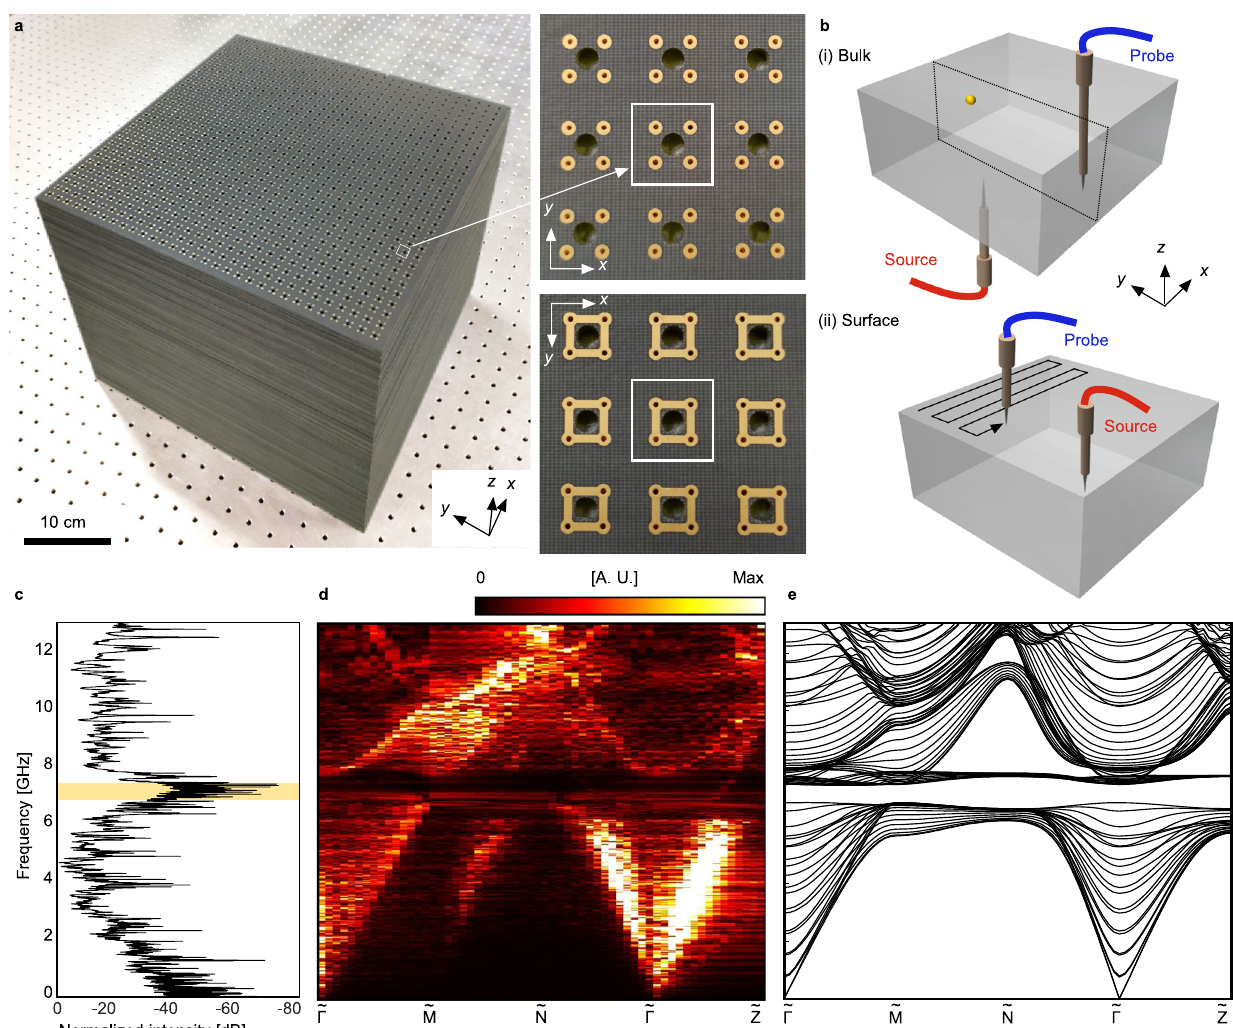
Fig. 2 Experimental setup and measurement of the bulk dispersion. a Photograph of the sample. Right insets denote magni fi ed images of top and bottom sides of the PCBs. b Experimental setups for (i) bulk and (ii) surface dispersion measurements. For bulk dispersion measurement, a dipole source antenna is placed at the bottom near the middle y – z plane (dashed box), and a dipole probe antenna is inserted into the sample to scan the middle y – z plane. For surface dispersion measurement, the probe antenna scans the top surface, while a dipole source antenna is placed slightly above the corner of the surface. c Normalized transmittance measured at the yellow marker in ( b ). Yellow region indicates a bulk bandgap. Measured ( d ) and simulated ( e ) bulk dispersions of the 3D